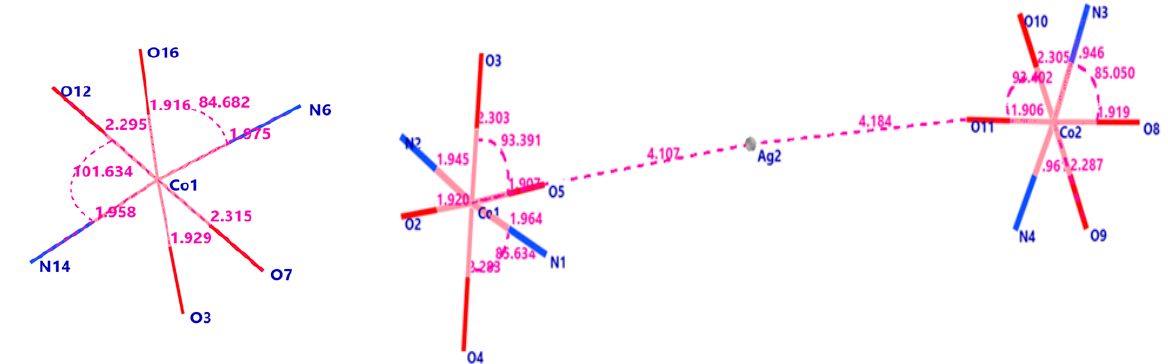
Figure 7. Bond distances and bond angles around Co(II) in PCC and PCCAg 0 NPs. The crystal structure is shown in Figure 8.